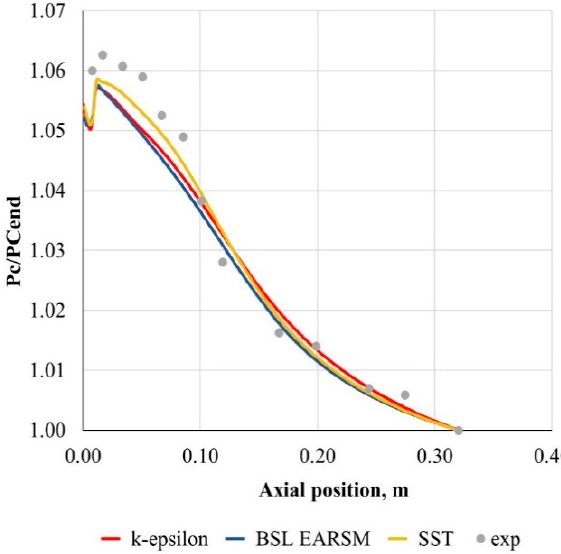
Figure 23. Normalized axial pressure distribution.